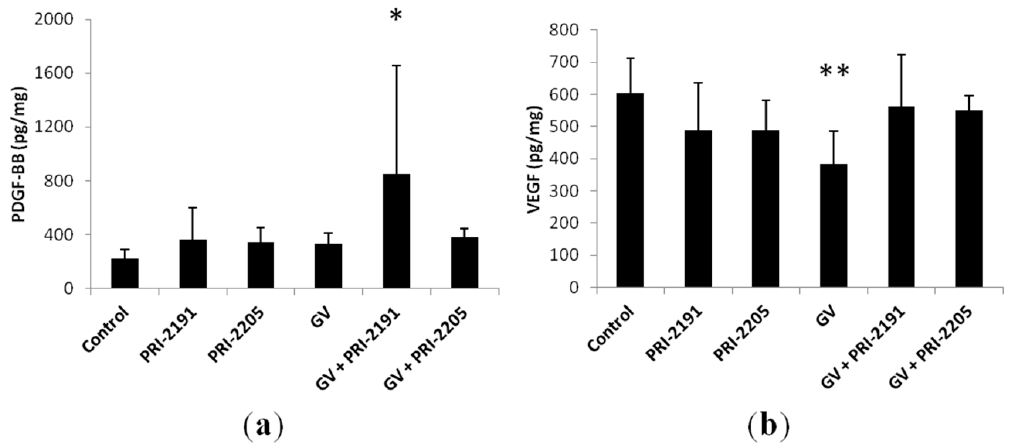
Figure 5. ( a ) PDGF-BB and ( b ) VEGF level (mean ± SD) in A549 tumor lysates harvested from mice treated with PRI-2191 and PRI-2205 alone or in combination with GV. GV, imatinib; PRI-2191 and PRI-2205, vitamin D analogs; * p < 0.05 compared to the control and GV, ** p < 0.05 compared to the control and GV + PRI-2191, ANOVA followed by Fisher’s test.